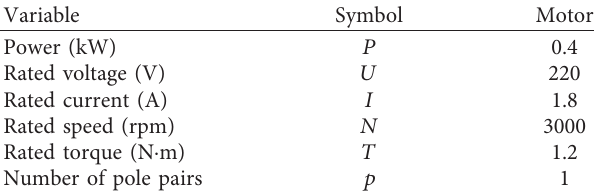
Table 5: Experimental motor mechanical parameters.